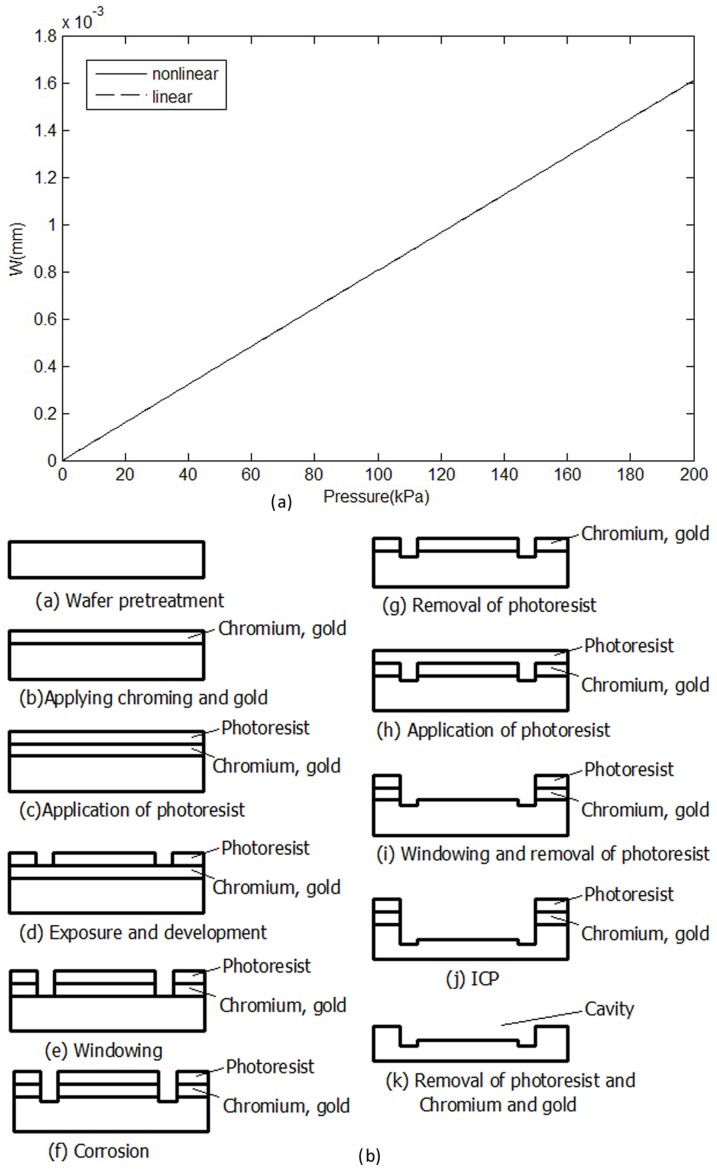
Production design of the cavity.(a) Correlation of deflection and pressure. (b)Production process of the diaphragm.